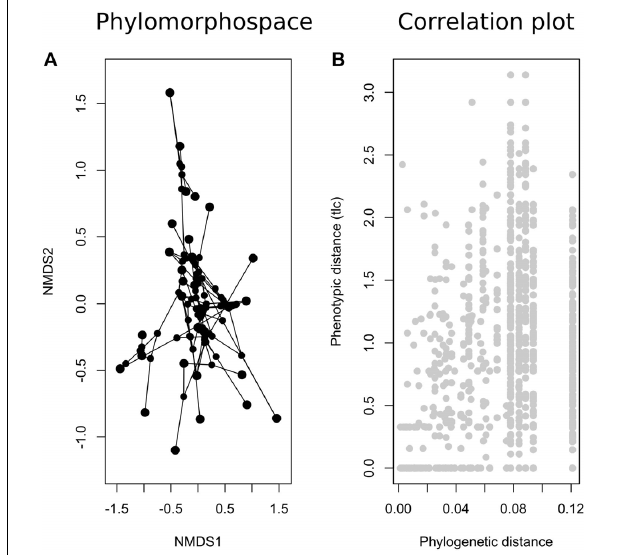
FIGURE 5 | Plots of the relationship between phenotypic divergence and phylogenetic distance. (A) a phylomorphospace plot; (B) a plot of phenotypic distance between pairs of samples based on HPTLC data set against the estimated phylogenetic distance extracted from the Bayesian phylogeny using a concatenated sequence data set of three loci (see Figure 1